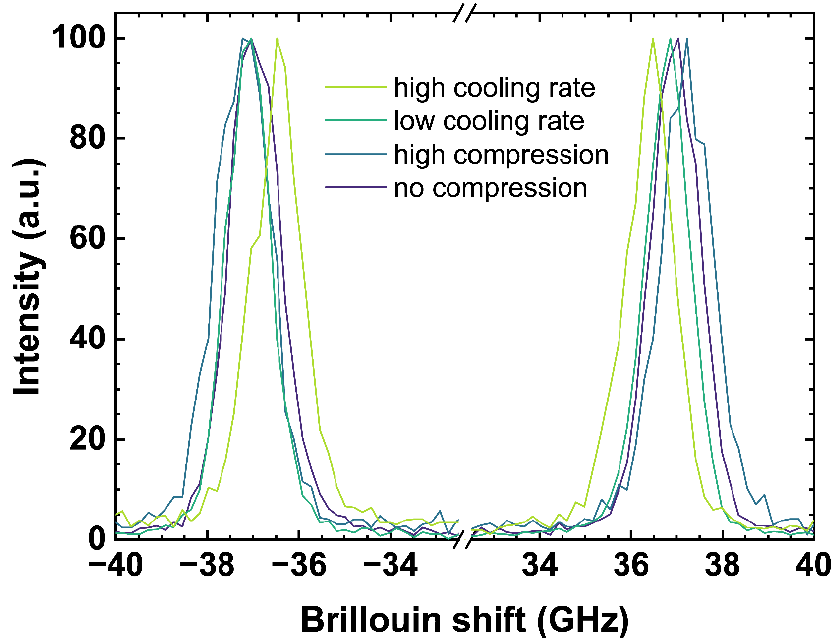
Figure 3. Brillouin spectra of OptiWhite q g 1 cooled with 6 × 10 − 4 K/min (low cooling rate) and 650 K/min (high cooling rate) as well as US_T g 1 under no uniaxial compression (0 GPa) and high uniaxial compression ( − 0.85 GPa). Negative shifts are related to the anti-Stokes signal ( left ) and positive shift to the Stokes signal ( right ), respectively.